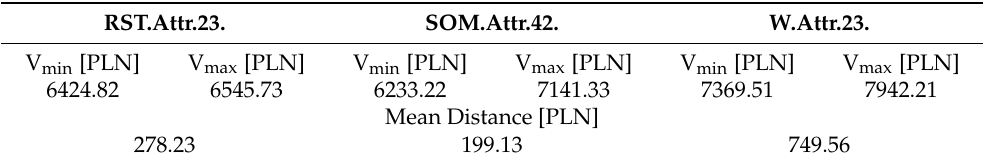
Table 9. Mean distances between the transaction price for the example benchmark property and the value range for the three models, illustrated using an example homogenous area. Source: own